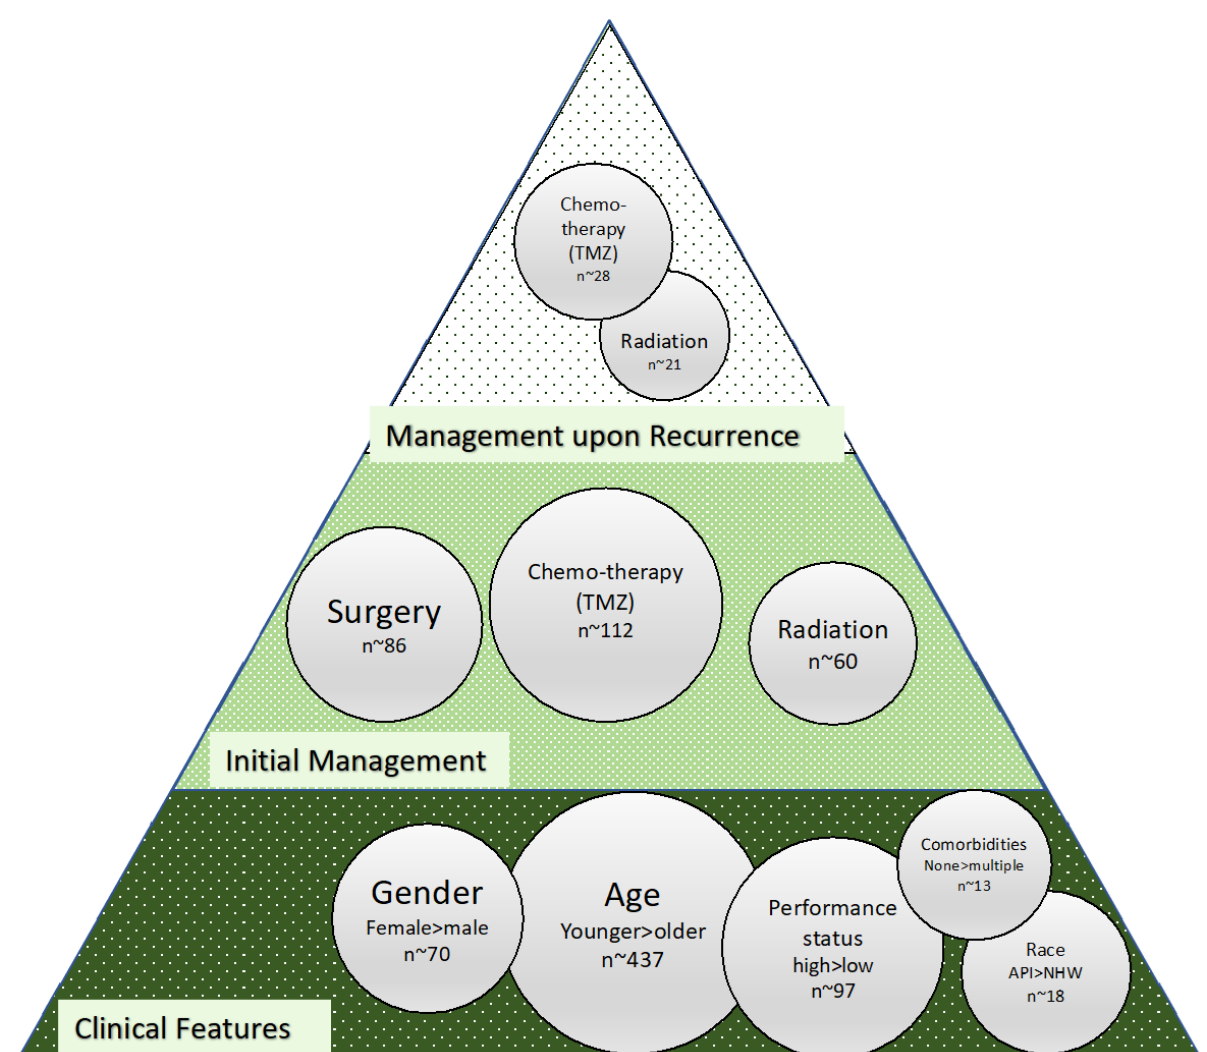
Figure 2. The current literature on patient characteristics is reported to be associated with outcomes in glioma (n indicates the number of articles reported in a PubMed search from 2012 to 2022) [73]. Bubble size for clinical features and treatments was determined based on PubMed search findings. MeSH terms used in the search for clinical features were “glioma”, “prognosis”, and “indicates” and for clinical features either “race”, “sex”, “performance status”, “age”, or “sex.” Terms used for initial management therapies were “glioma”, “prognosis”, “indicates”, “initial”, and either “surgery”, “radiation”, or “chemotherapy”. For recurrent tumor treatment bubbles, the same search was used with the term “recurrent” instead of “initial.” All searches were filtered for only articles in the last 10